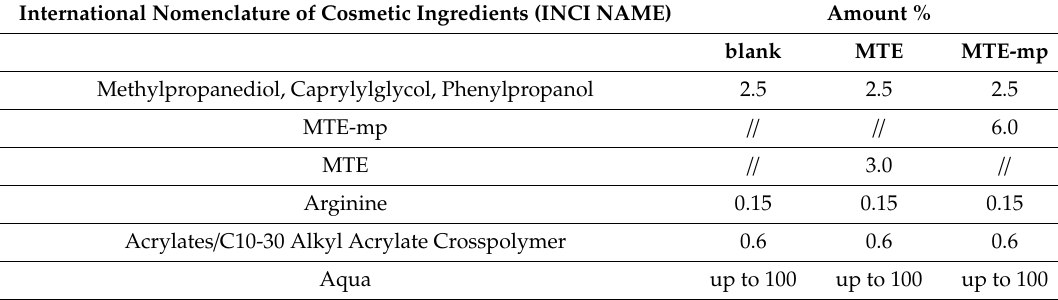
Table 3. Composition of